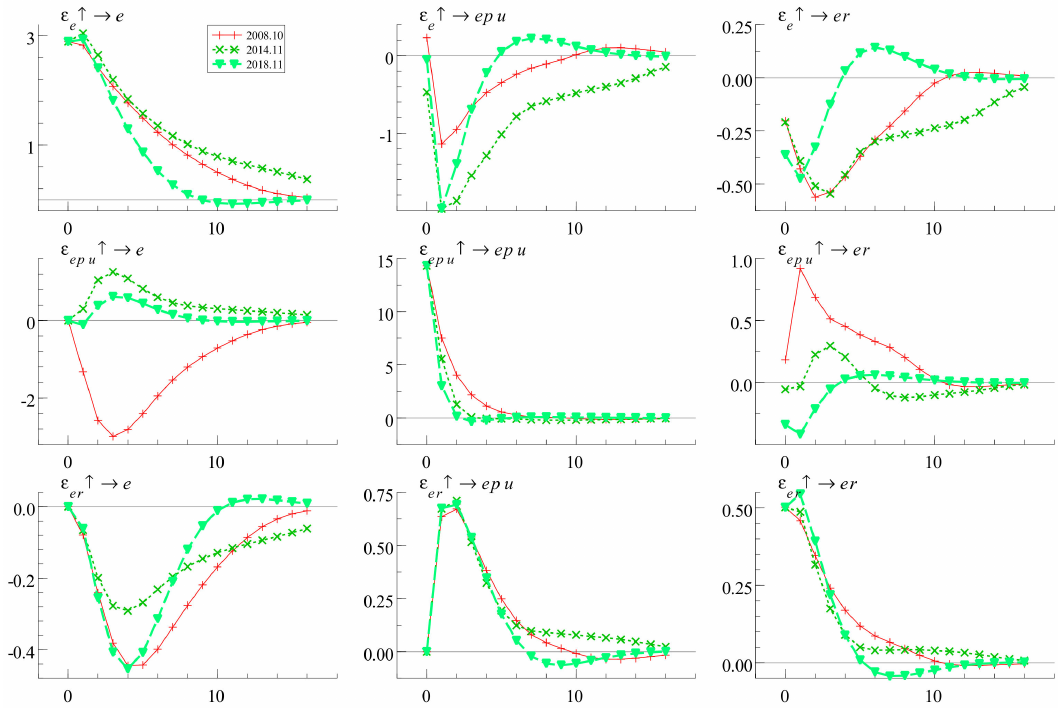
Figure 5. Time-varying impulse responses of the TVP-VAR model for structural breaks (continued). Notes: 1. Horizontal axes indicate the number of months after a shock. 2. Vertical axes represent the standardized responses to shocks for each